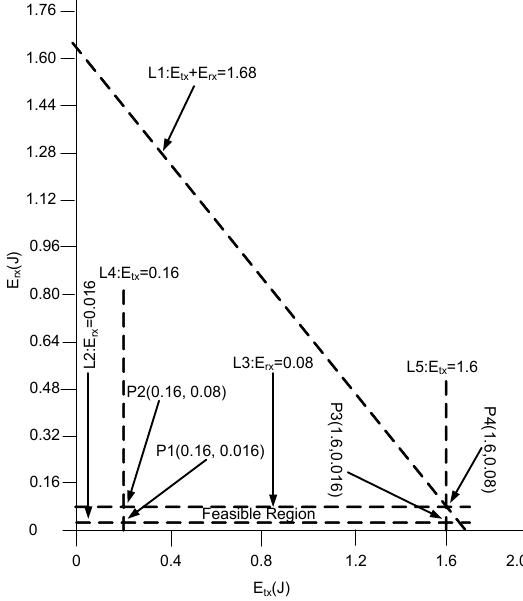
Figure 7. Feasible region for energy